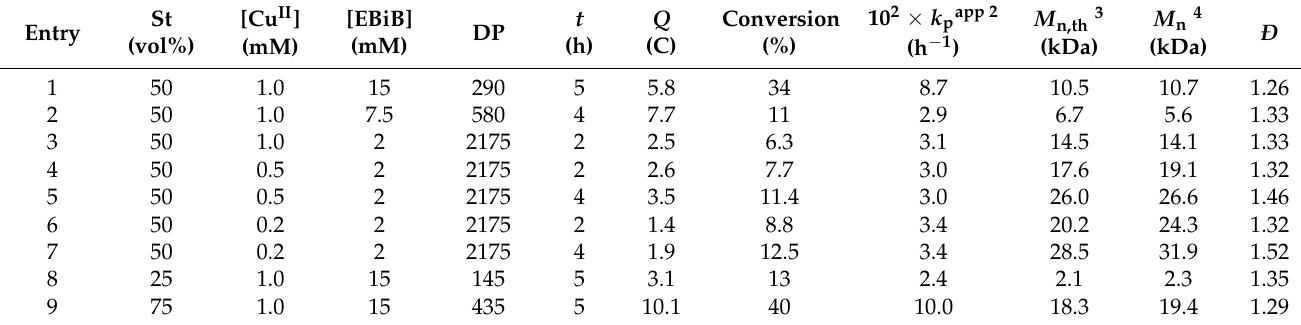
Table 3. Potentiostatic e ATRP of styrene in DMF initiated by EBiB at 80 ◦ C 1 .